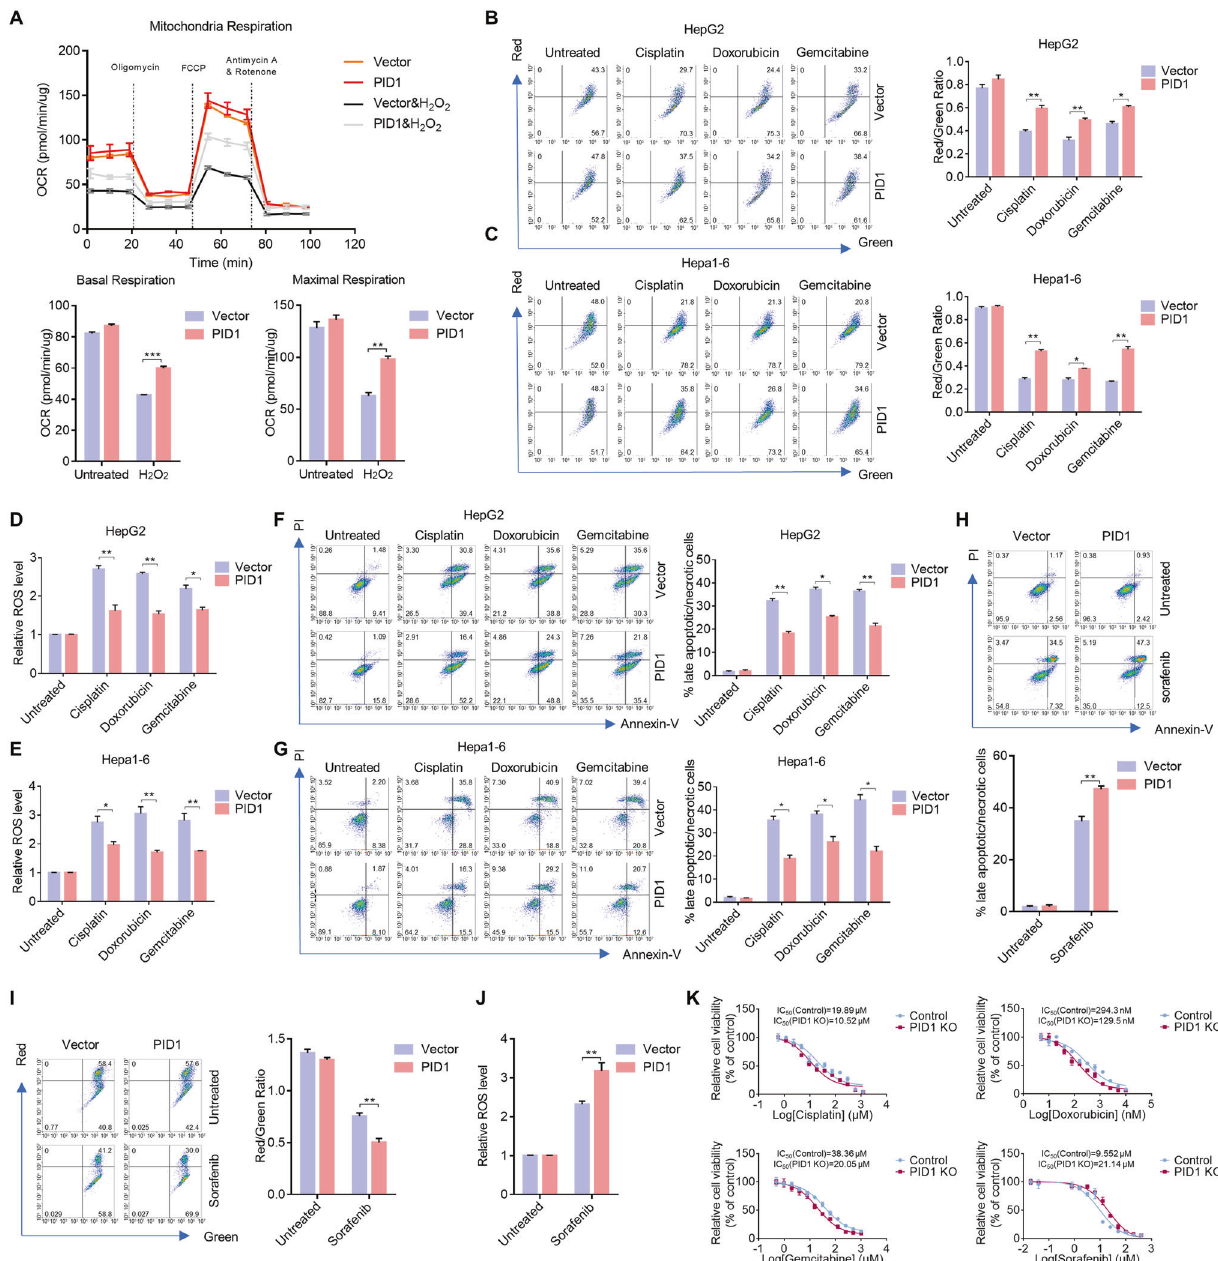
Fig. 2 PID1 reduced ef fi cacy of chemotherapeutic agents but facilitated Sorafenib-induced apoptosis. A Seahorse analysis was performed to evaluate the capacity of mitochondria respiration in HepG2 cells with or without PID1 overexpression upon H 2 O 2 (200 μ M) treatment for 12 h, basal respiration rate and maximum respiration rate were calculated. B – C Mitochondrial membrane potential in HepG2 cells and Hepa1 – 6 cells with or without PID1 overexpression upon treatment of three anticancer agents was detected by cytometry analysis and Red/ Green ratio was calculated. D – E HepG2 cells and Hepa1 – 6 cells were treated with Cisplatin (20 μ M), Doxorubicin (200 nM) and Gemcitabine (20 μ M) for 24 h. Intracellular ROS in HepG2 cells and Hepa1 – 6 cells with or without PID1 overexpression upon treatment of three anticancer agents was detected by cytometry analysis and MFI was calculated. F-G Cell apoptosis in HepG2 cells and Hepa1 – 6 cells with or without PID1 overexpression upon treatment of three anticancer agents. H Cell apoptosis in HepG2 cells with or without PID1 overexpression upon Sorafenib (10 μ M) treatment for 24 h was examined by cytometry analysis. I Mitochondrial membrane potential in HepG2 cells with or without PID1 overexpression upon Sorafenib (10 μ M) treatment for 24 h was assessed by cytometry analysis and Red/Green ratio was calculated. J Intracellular ROS in HepG2 cells with or without PID1 overexpression upon Sorafenib (10 μ M) treatment for 24 h was assessed by cytometry analysis and MFI was calculated. K Cell viability curves of Hep3B cells with or without PID1 de fi ciency treated with the indicated doses of anticancer agents for 24 h. Data are expressed as mean ± SD ( n = 3). * p < 0.05; ** p < 0.01; *** p < 0.001.